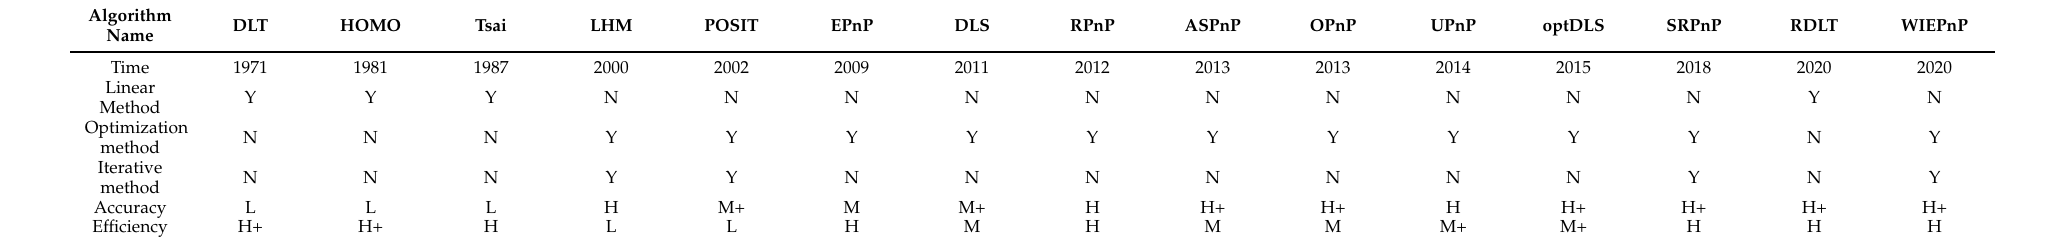
Table 1. The development of each PnP algorithm. (Note: Y means adopted, N means not adopted, L means Low, M means Median, H means Hight, + means better than this level, but worse than the next